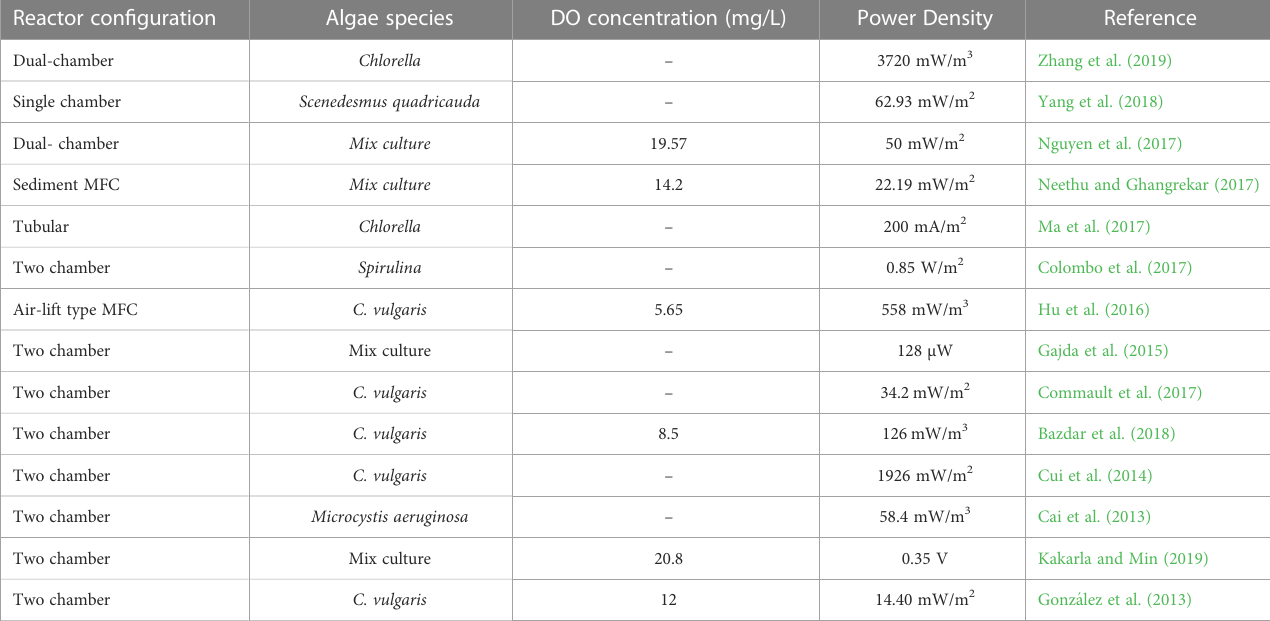
TABLE 4 Different species of microalgae and the corresponding dissolved oxygen (DO) and power output obtained in algae assisted MFCs. Reactor con fi guration Algae species DO concentration (mg/L) Power